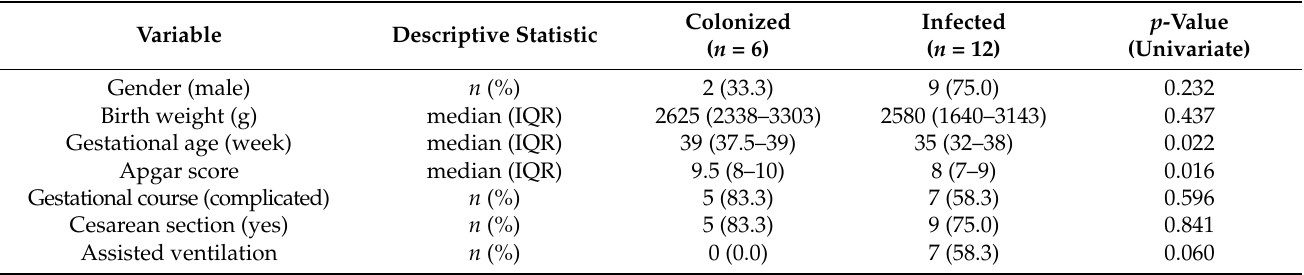
Table 2. Risk factors of extended-spectrum β -lactamase-producing Klebsiella pneumoniae colonized and infected